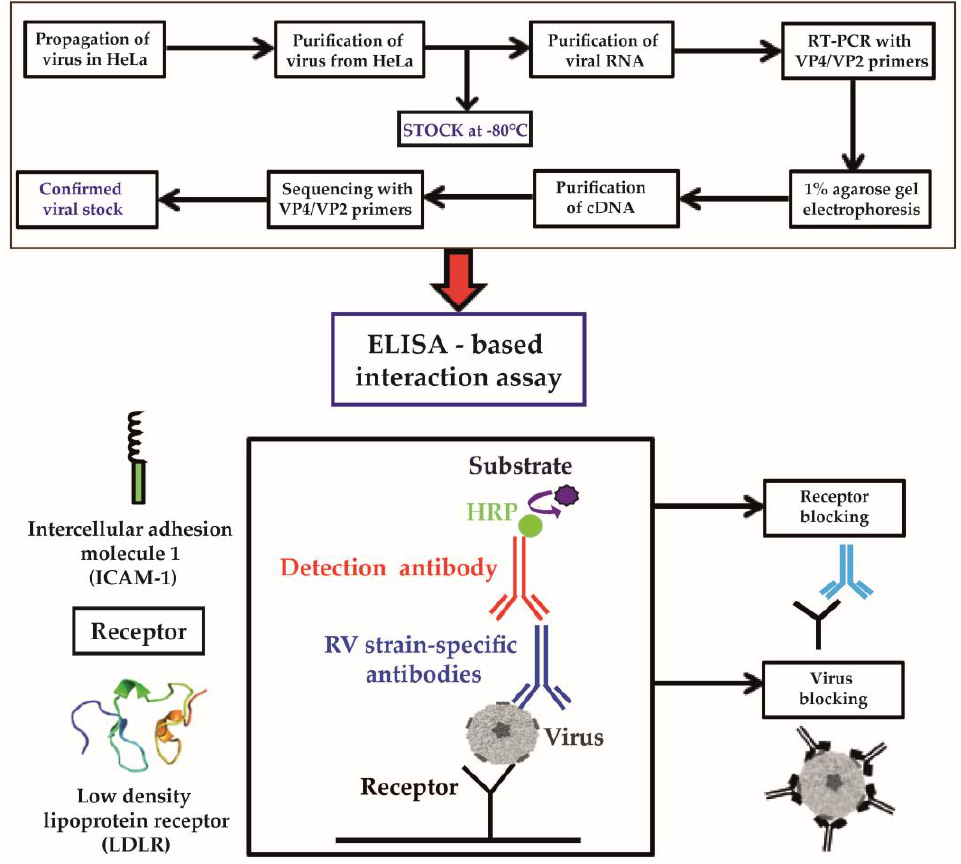
Figure 1. Flow chart summarizing the experimental design and reagents for the ELISA-based virus–receptor interaction assay. (top) The preparation of viral strains and the confirmation of their identity by reverse transcription (RT)-PCR. (bottom) The scheme for the ELISA detection of virus–receptor interactions.